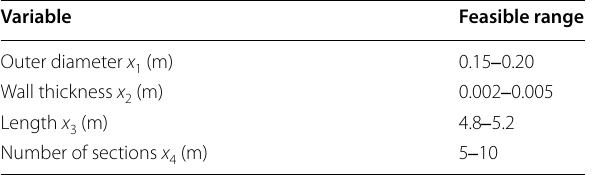
Table 7 Feasible ranges for parameters Variable